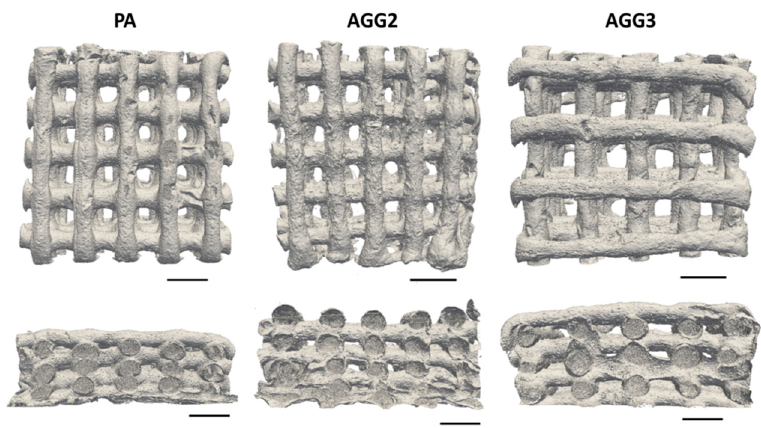
scale bar = 500 µ m). Polymers 2016 , 8 , 170 scale bar = 500 µm).